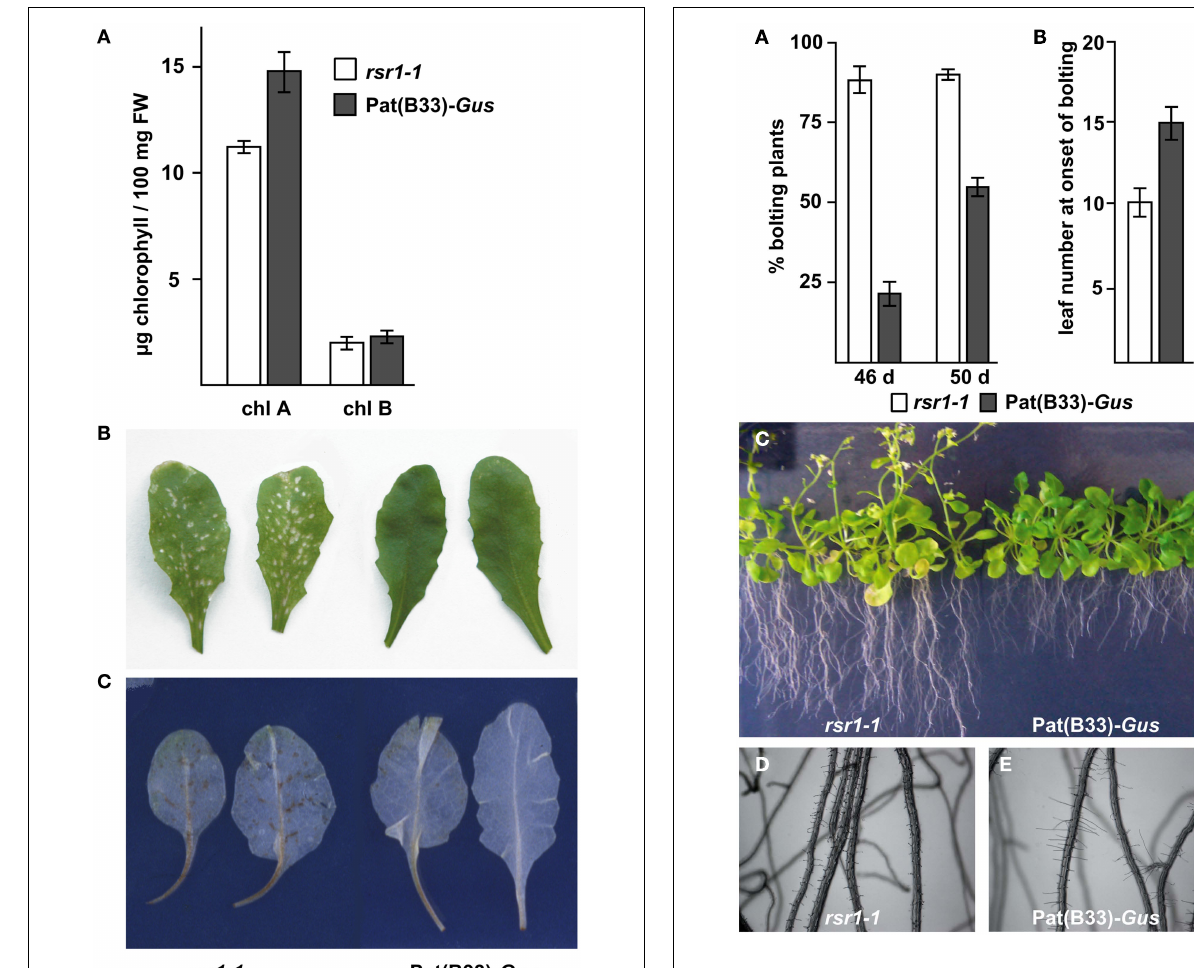
FIGURE 2 | rsr1-1 is early flowering and has an altered root morphology. (A) Under short-day conditions rsr1-1 plants started flowering much earlier than the parental line Pat(B33)- Gus . (B) Under long-day conditions, rsr1-1 plants formed fewer primary rosette leaves than Pat(B33)- Gus . In (A,B) the values presented are the mean ± SD of ≥ 15 plants. (C) In sterile culture on MS-medium with 60mM Suc, rsr1-1 mutants maintained the early flowering phenotype and produced roots nearly twice as long as those of Pat(B33)- Gus. Under the same conditions, root hairs were shorter in rsr1-1 (D) than in Pat(B33)- Gus (E) and slightly irregular in